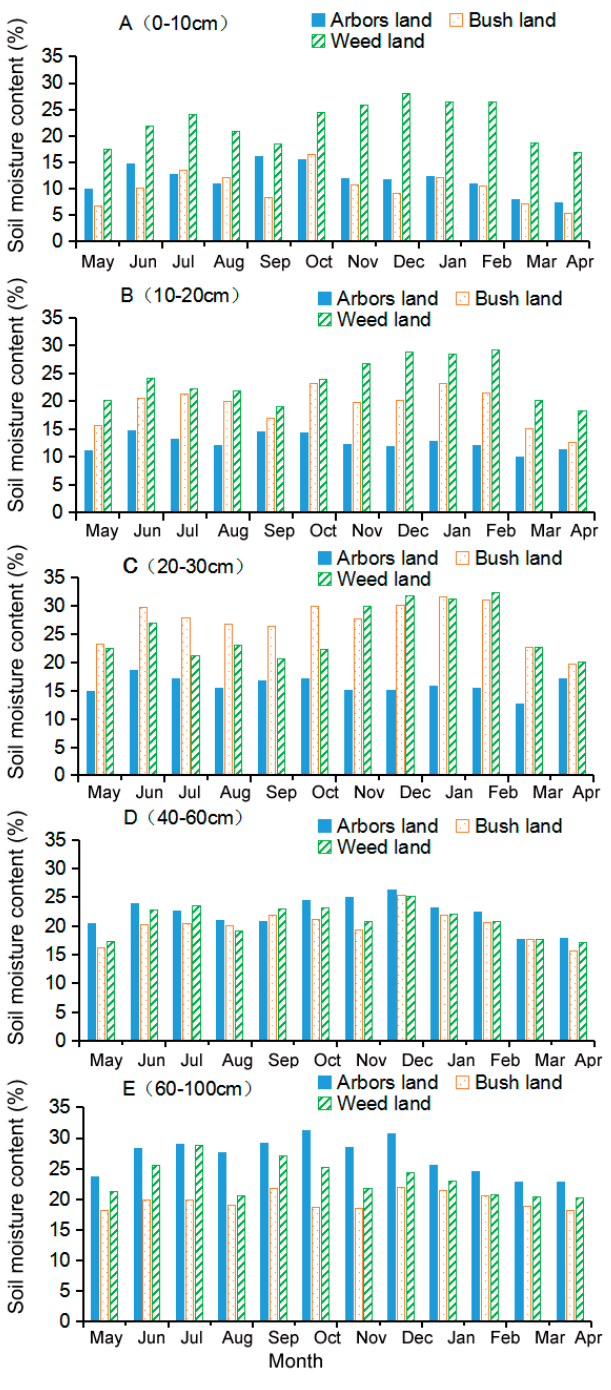
Figure 6. Monthly average soil moisture content in three different site types between 2012 to 2016. (3) On the seasonal scale (Figure 7): There were significant differences in SMC among the three different site types. The SMC in arbors forest land appeared as a linear curve in the rainy and dry seasons. The SMC also increases as the depth increases. The SMC curves of bush land in the rainy and dry seasons were waveform in shallow soil lay- ers and linear in deep soil layers. The SMC increased with soil depth and reached the maximum value at 20 cm, then gradually decreased to the minimum value at 40 cm. SMC tended to be stable at 40 cm to 100 cm. The SMC curves of weed land showed a circular shape from 10 cm to 60 cm and linearly increased after reaching the mini- mum value at 60 cm.